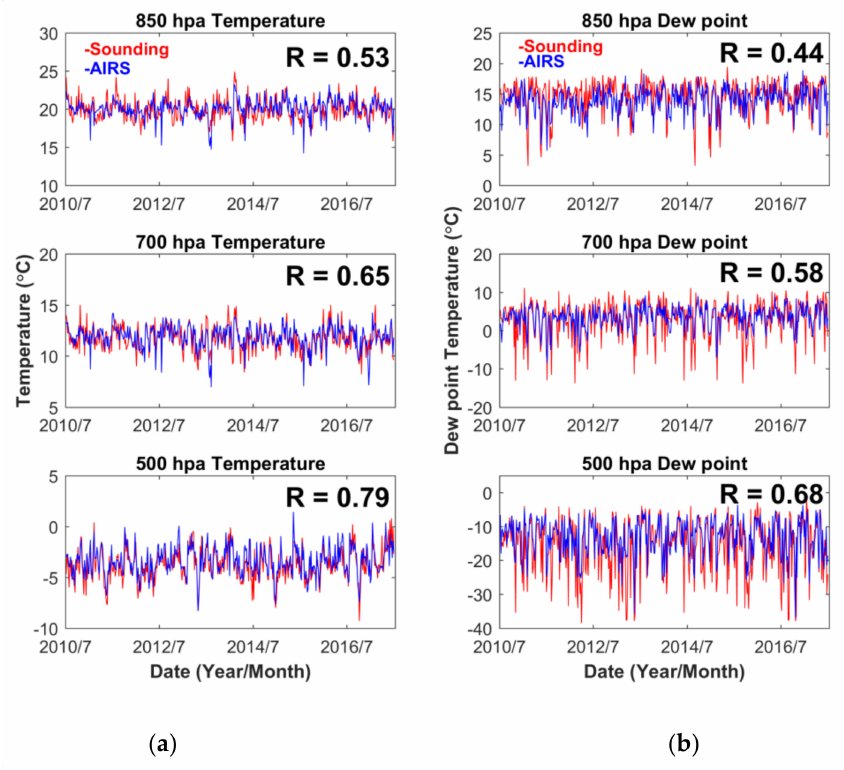
Figure 4. Comparison of AIRS (blue line) and radiosonde (red line) for ( a ) temperature, and ( b ) dew point for 850, 700, and 500 hPa (from top to bottom).